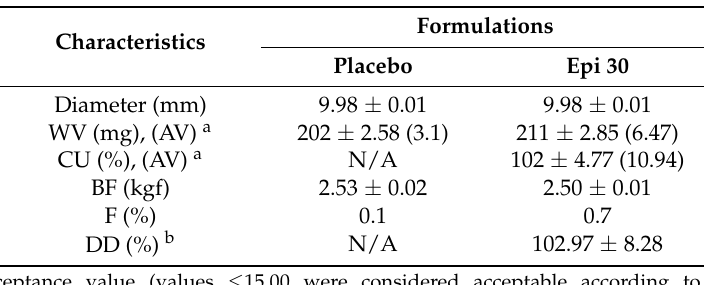
Table 2. Mean ± SD diameter, weight variation (WV), content uniformity (CU), breaking force (BF), friability (F), and drug dissolution (DD) for the taste-masked rapidly-disintegrating sublingual tablet